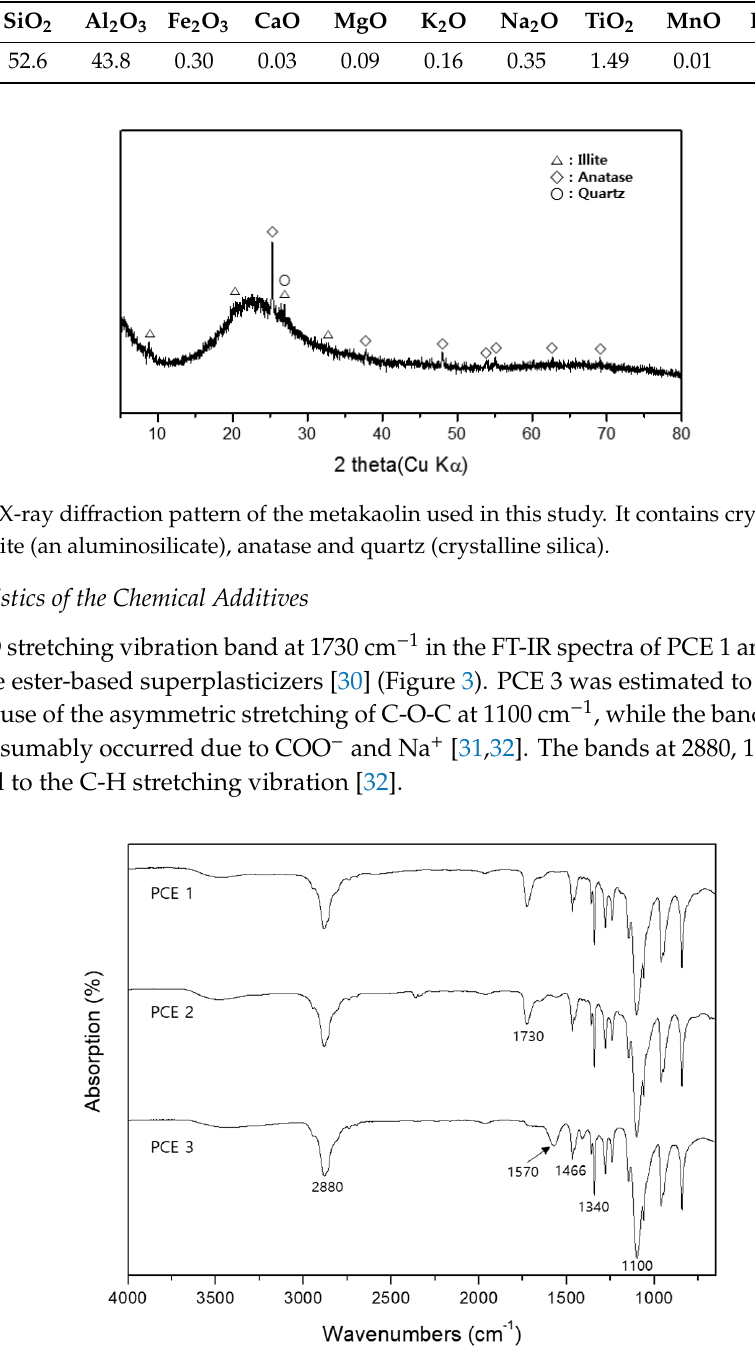
Table 2. Content of the major elements in the metakaolin used in this study, as determined by X-ray di ff raction (XRD).